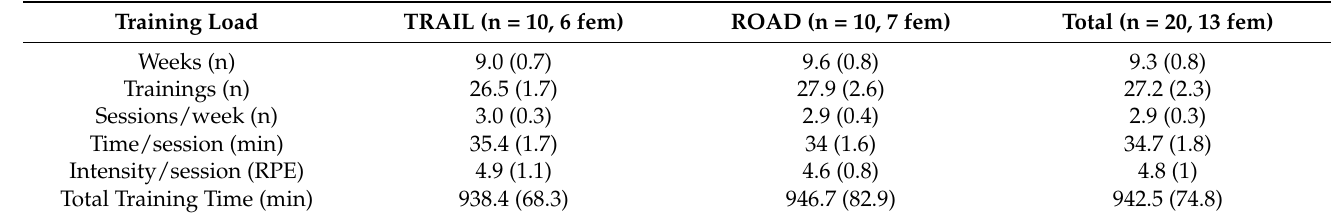
Table 2. Training load of trail and road physical activity interventions. Values are mean ±